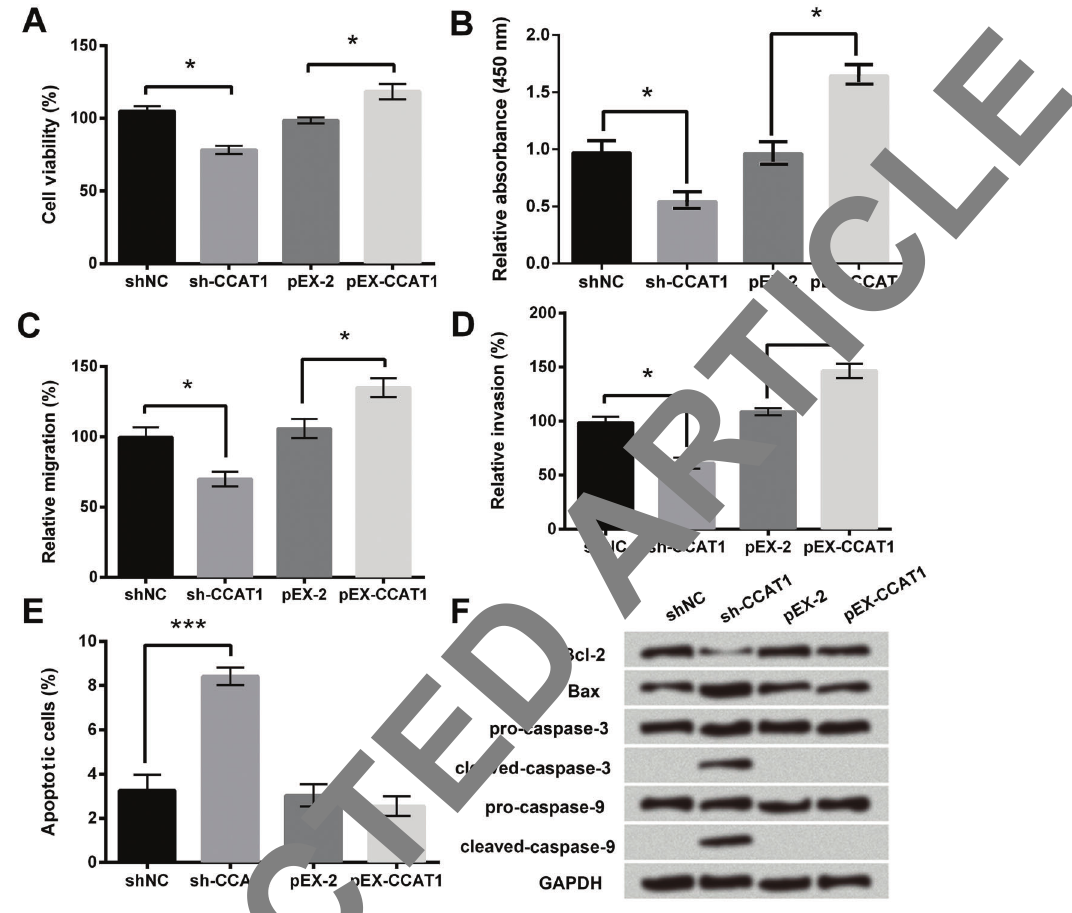
Figure 2. CCAT1 increased cell viability, proliferation, migration, and invasion in FTC-133 cells. Cells were transfected with CCAT1 expressing vector or CCAT1 shRNA. A to E , Cell viability, proliferation, migration, invasion, and apoptosis were measured using